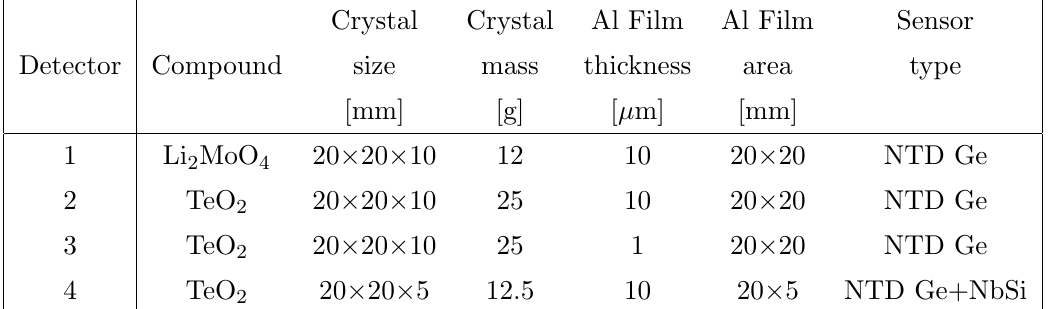
Table 1 . Main characteristics of the four detectors described in the text. An uranium (cid:11) source irradiates the (cid:12)lm in all the detectors. A polonium (uranium) (cid:11) source irradiates a bare side of the crystal in detector 2